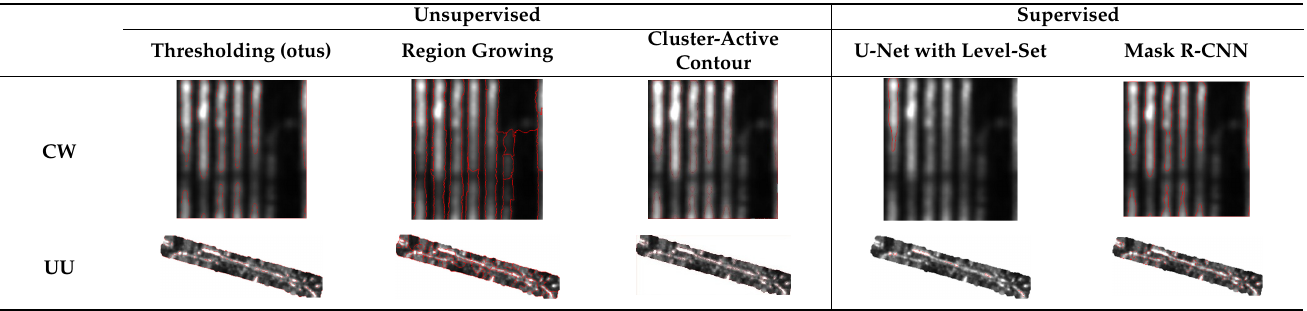
Figure 5. Original C-scans and segmented reference images of four representative cases named CW, CS, UU, and YL.